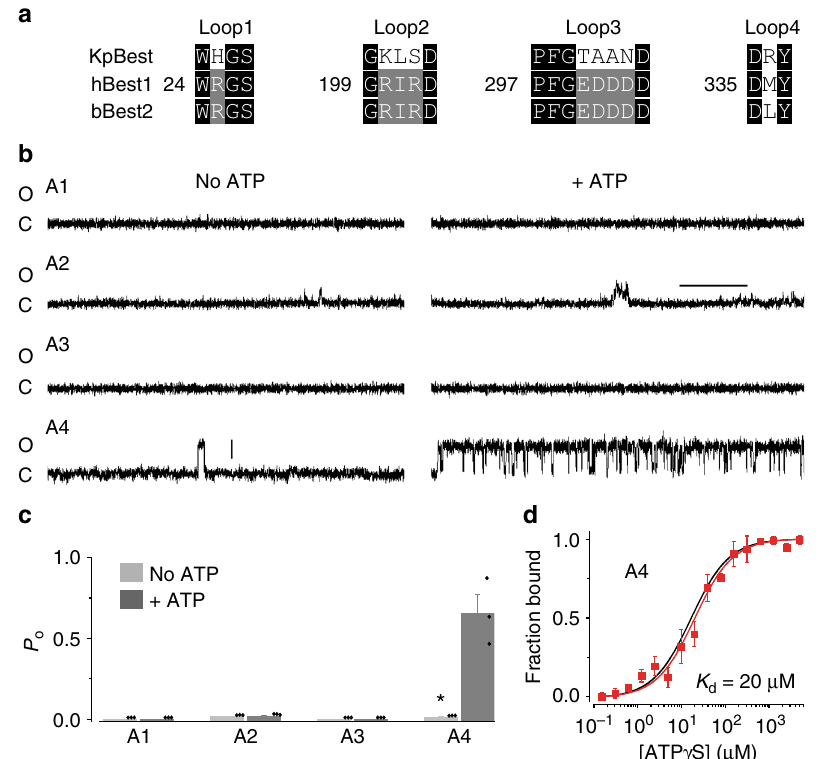
Fig. 4 Mapping ATP-binding motif(s) in KpBest. a Candidate ATP-binding motifs in KpBest, hBest1, and bBest2. Black background, identical residues in all three sequences; gray background, identical residues in two sequences. Numbers indicate the position of the fi rst residue in each motif on hBest1. b Current traces of single KpBest mutant channels recorded from planar lipid bilayers at 80 mV in the absence or presence of 2 mM ATP (Scale bar, 3.5 pA, 250 ms). c Bar chart showing the open probability of KpBest mutant channels in the absence or presence of 2 mM ATP. n = 3 for each bar. * P < 0.05 compared to currents from the same channels in the presence of ATP, using two-tailed unpaired Student t test. d The MST binding curve of KpBest A4 to ATP γ S (red). Protein fraction bound vs. [ATP γ S], n = 3 for each point. The binding curve of WT KpBest to ATP γ S (black) is shown for comparison. All error bars in this fi gure represent